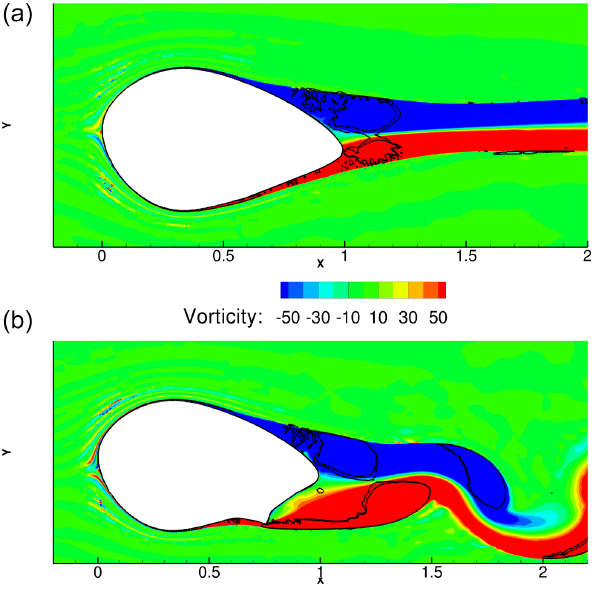
Figure 12. Vorticity contour plot with Q-criteria lines for α = 6 ◦ and Re c = 3 × 10 6 : (a) no spoiler case and (b) spoiler case. Red is anticlockwise flow rotation, and blue is clockwise flow